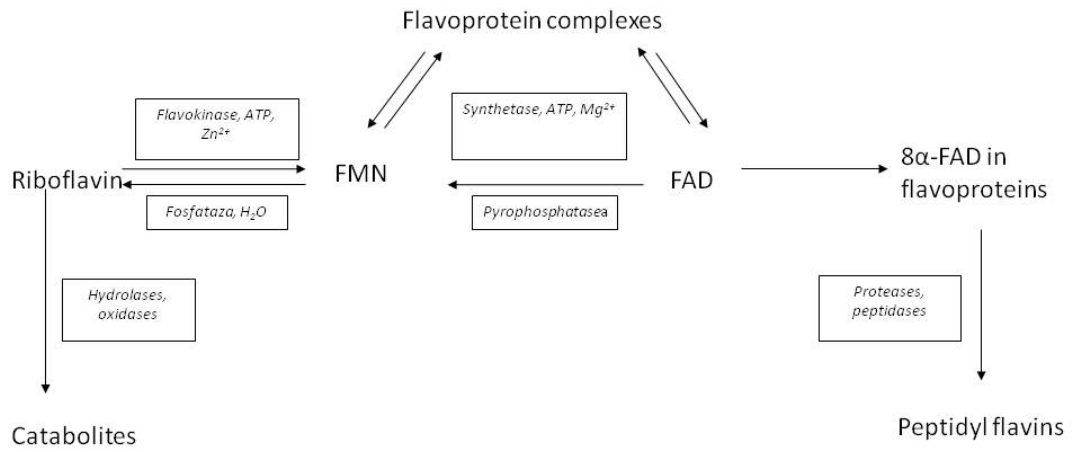
Figure 1: Metabolism of riboflavin